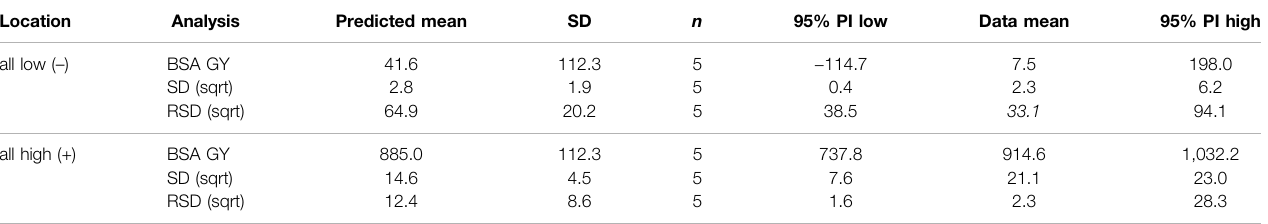
TABLE4| Con fi rmationofresponsemodels(MR5design).Twosettingswereexamined(factorlevelsalllow,andallhigh),andthedatameanwascomparedtothepredicted mean and the 95% prediction interval (PI). Responses SD and RSD had to be transformed using a square root function indicated as (sqrt). Location